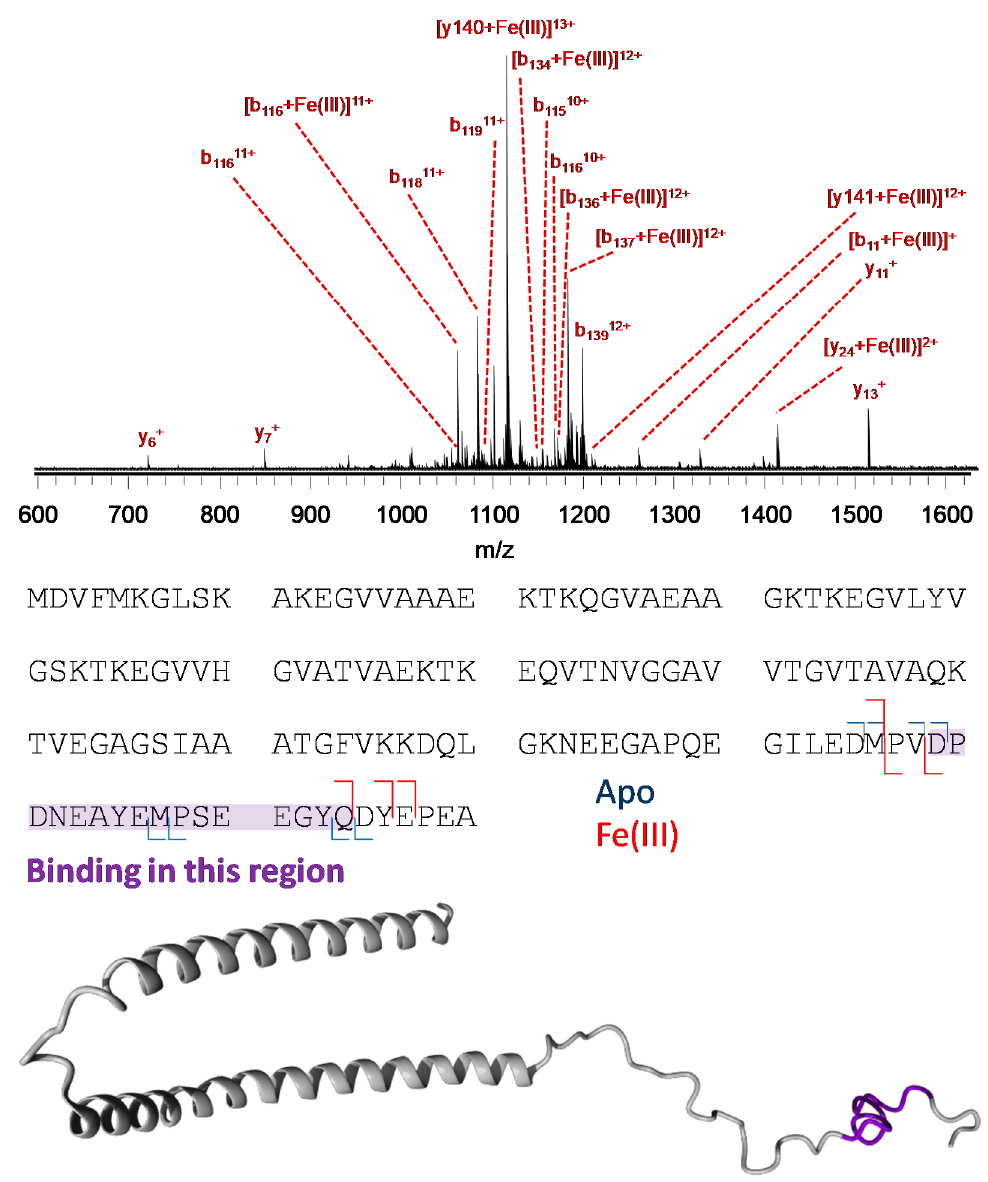
Figure A3. Tandem MS analysis of the [ α -syn + Fe(III)] complex, showing results from CID fragmentation of [ α -syn + 13H + Fe(III)-NTA 3- ] 13 + . The fragments are summarized below the mass spectrum, and the possible binding region is indicated. A 3D structural representation of α -syn is shown at the bottom, with the possible binding region colored purple. Fe(III) was added as a 1:1 complex with NTA 3- to stabilize it towards hydrolysis, precipitation, and aggregation at pH 7. The ligand is lost before backbone fragmentation occurs, and hence metal-bound fragments are detected carrying the free Fe(III) cation.